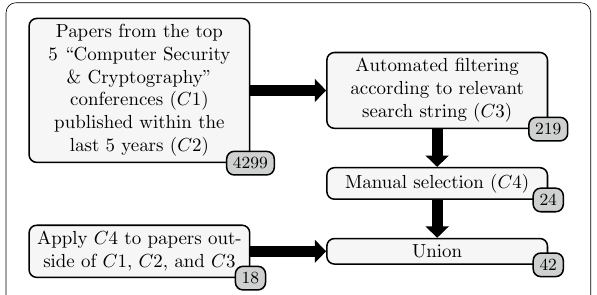
Fig. 1 The selection process for finding relevant works, including the numbers of papers each step has mined